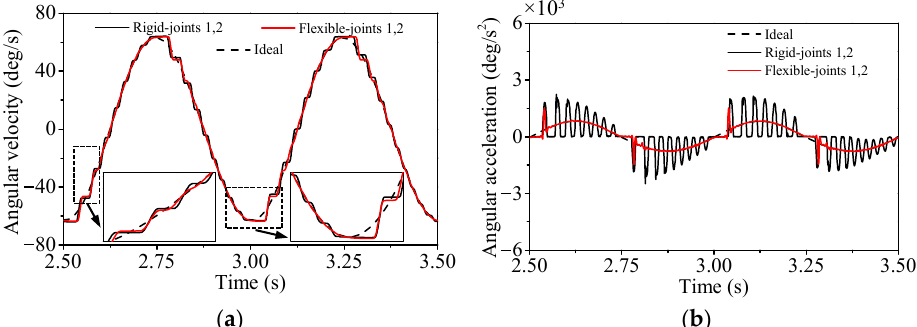
Figure 20. Effects of clearances at joints 1 and 2 when considering the flexibility of the auxiliary rod: ( a ) angular velocity; ( b ) angular acceleration.